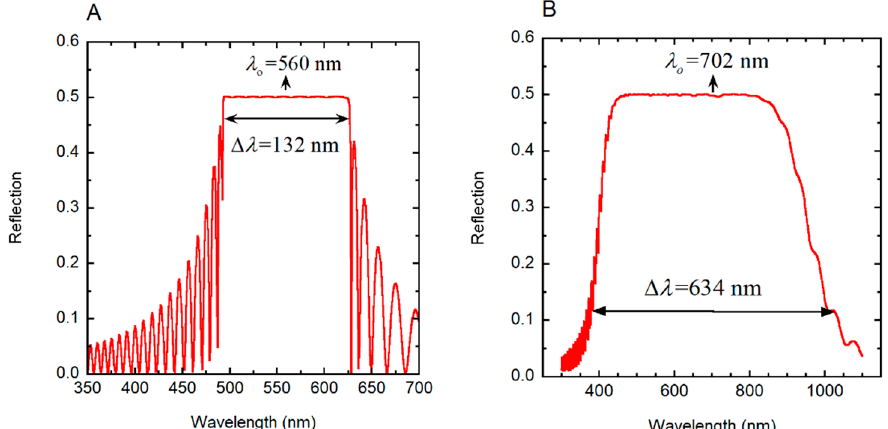
Figure 7. Reflection by chiral structures when normally illuminated with non-polarized light. ( A ) Total reflection spectrum of a cholesteric liquid crystal with the following specification: P o = 330 nm, H = 16 P o , Δ n = 0.40 and n o = 1.5 [56]. ( B ) Reflection spectrum of a linearly graded left-handed twisted cholesteric liquid crystal, whose pitch is given by P ( z ) = P m (1 + az/H ) with a = 0.458, H = 24 P m , P m = 240 nm, Δ n = 0.40, and n o = 1.5. Normal illumination of non-polarized radiation is assumed.